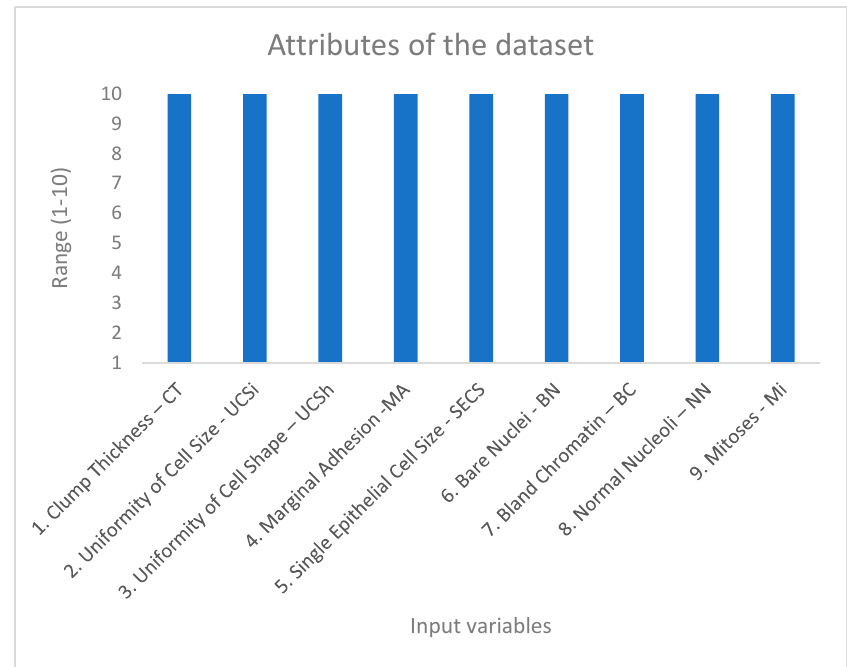
Figure 2. Input variables of the Wisconsin Breast Cancer dataset.